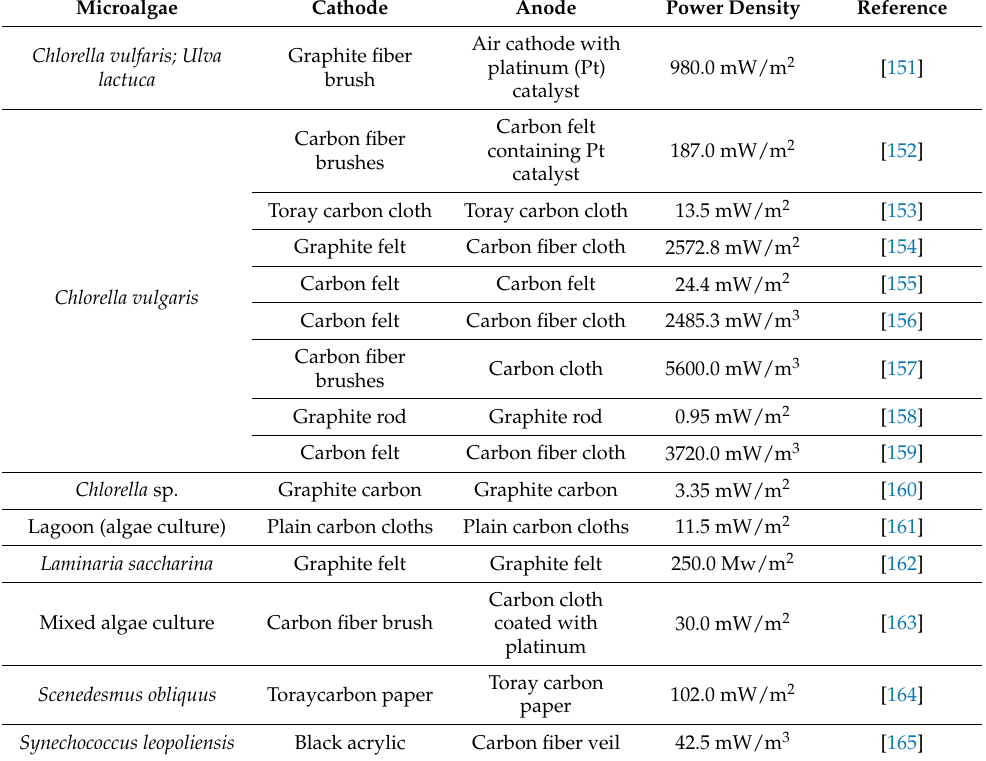
Table 7. Different microalgae used for bioelectricity